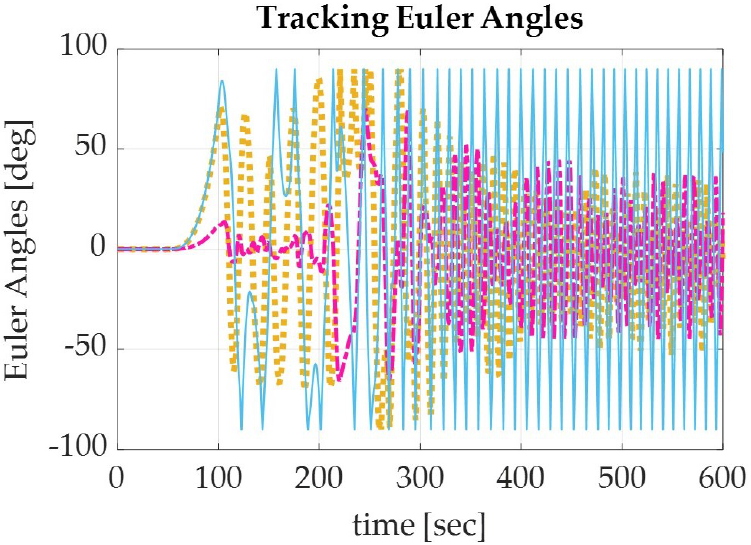
Figure 7. Graph of the Euler angle tracking for a spacecraft de-orbiting from LEO altitude (1000 km) using the Pontryagin’s autonomous trajectory for roll (yellow), pitch (pink), and yaw